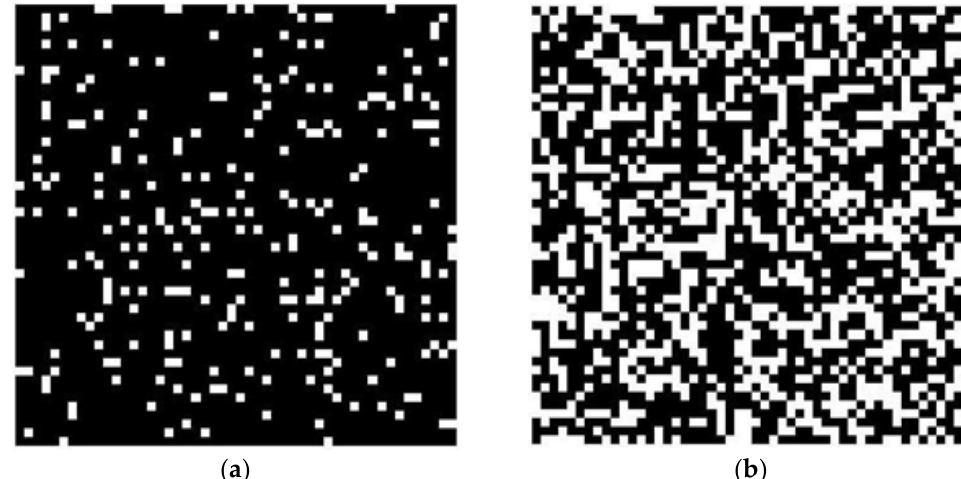
Figure 3. Initial pore distribution: ( a ) φ = 0.1; ( b ) φ = 0.4.